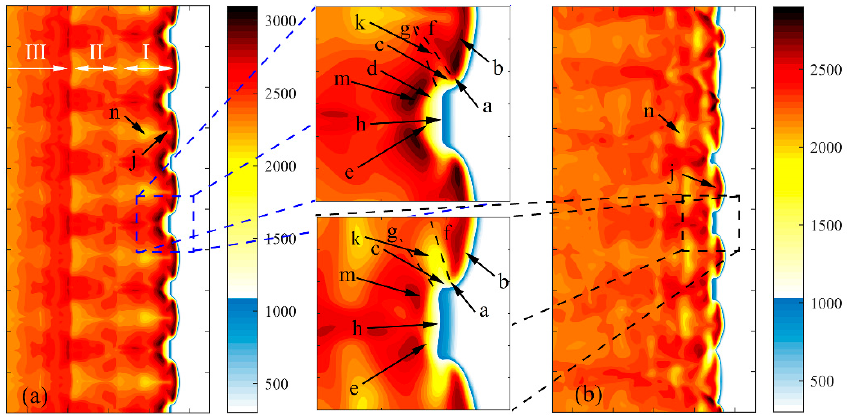
Figure 9. The instantaneous temperature distribution of the detonation wave at ( a ) ER is 3.0; ( b ) ER is 6.0. The propagation direction is from left to right. a, triple point; b–e, flame front; f, g, slip line; h, induction zone; j, m, gas region after flame front; k, unreacted pocket; n, low temperature zone; I, II, III, different reaction zone.